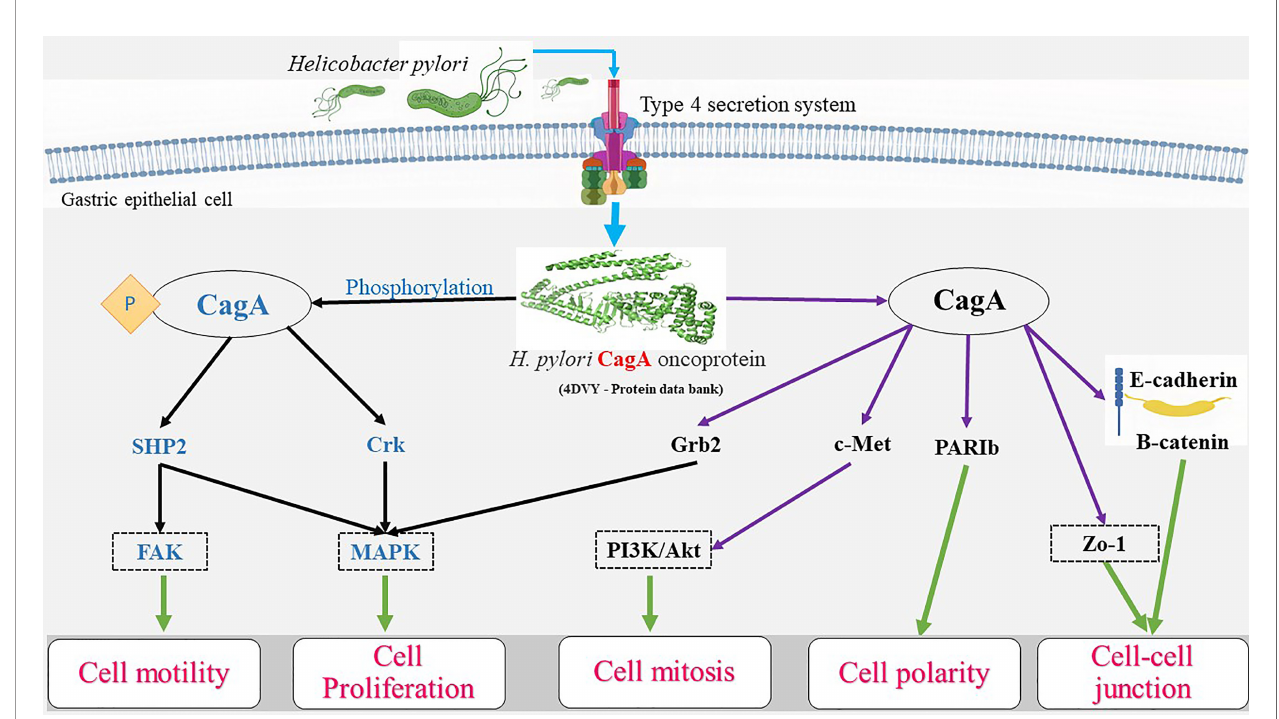
FIGURE 1 | Roles of phosphorylated and non-phosphorylated cagA in neoplastic